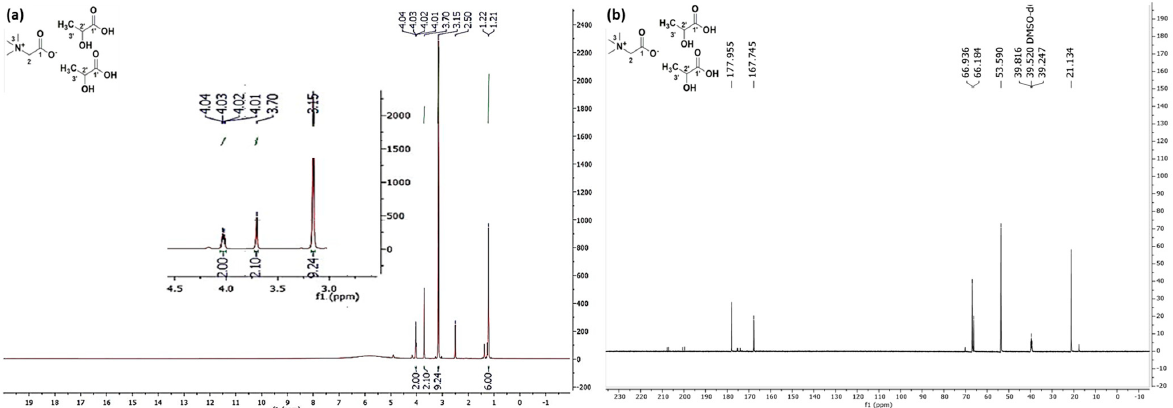
Figure 2. ( a ) 1 H NMR and ( b ) 13 C NMR spectrum of the NaDES Bet/LA/W (1:2:2.5) (600 MHz, DMSO-d 6 ).